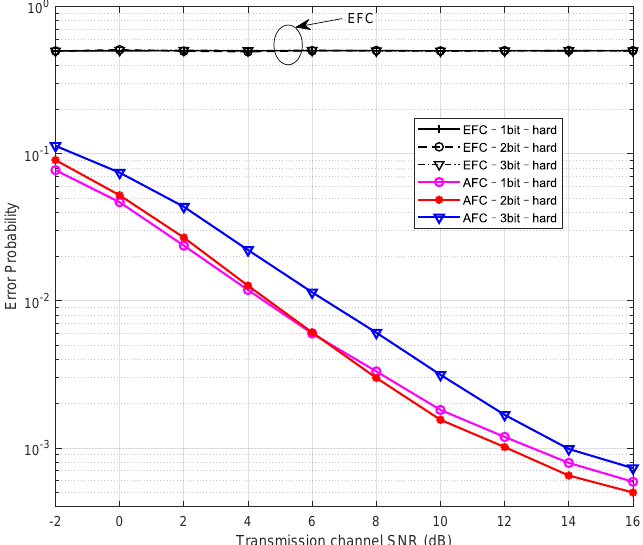
Figure 7. Error probabilities of the hard data fusion varying with the SNR of transmission channel for β = 0.8 and snr L = 5